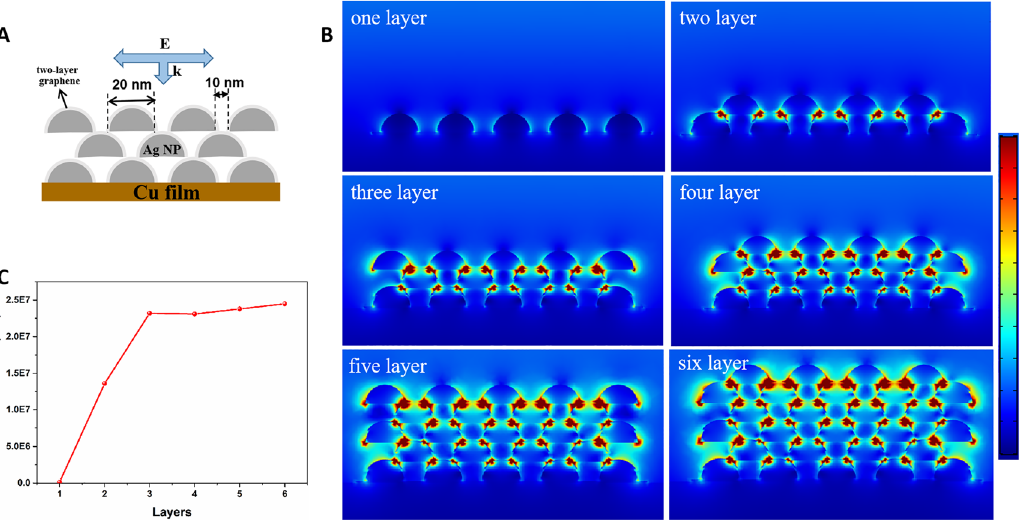
Figure3: (A)Simulationset-upoftheMAgNP-CuFsubstrate.(B)They – zviewsofelectricfielddistributionforMAgNP-CuFwithdifferentAgNP/ graphene layers at 532 nm wavelength. (C) Electric fi eld enhancement (E/E 0 ) for the